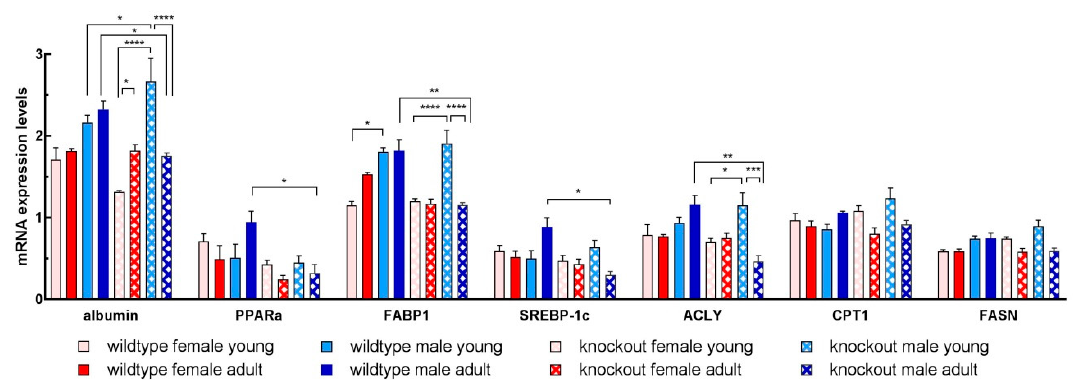
Figure 7. Levels of mRNA coding for proteins involved in lipid metabolism and function in isolated hepatocytes of wildtype and knockout female and male mice Expression was quantified by semi-quantitative analysis of PCR products and the signals were normalized to the reference genes. Differences between groups were considered significant, if the p -value was ≤ 0.05 (denoted “*”; whereas p ≤ 0.01, 0.001, and 0.0001 are denoted as “**”, “***”, and “****”, respectively).